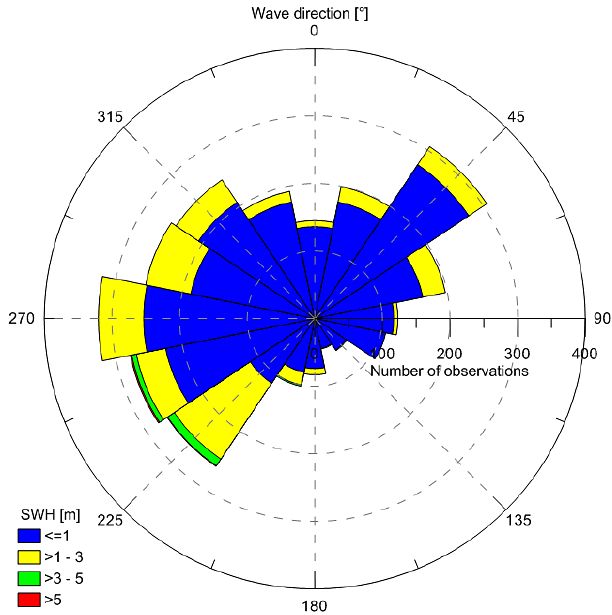
Figure 20. Wave rose at the point indicated on Fig. 16 in 2007.